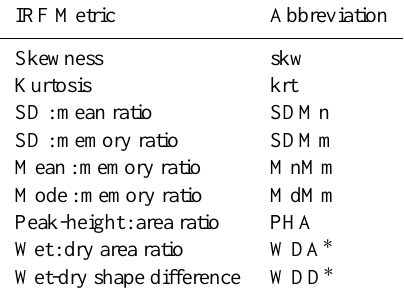
Table 2. Impulse-response function (IRF) metrics. Metrics quanti- fied separately for wet and dry periods are designated by the sub- script “w” or “d”, respectively, at the end of the